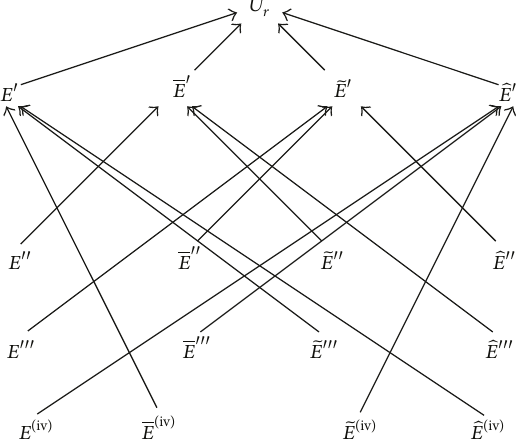
Figure 12: The causal structure of the RPS in a ( 3 + 1) -dimensional spacetime.